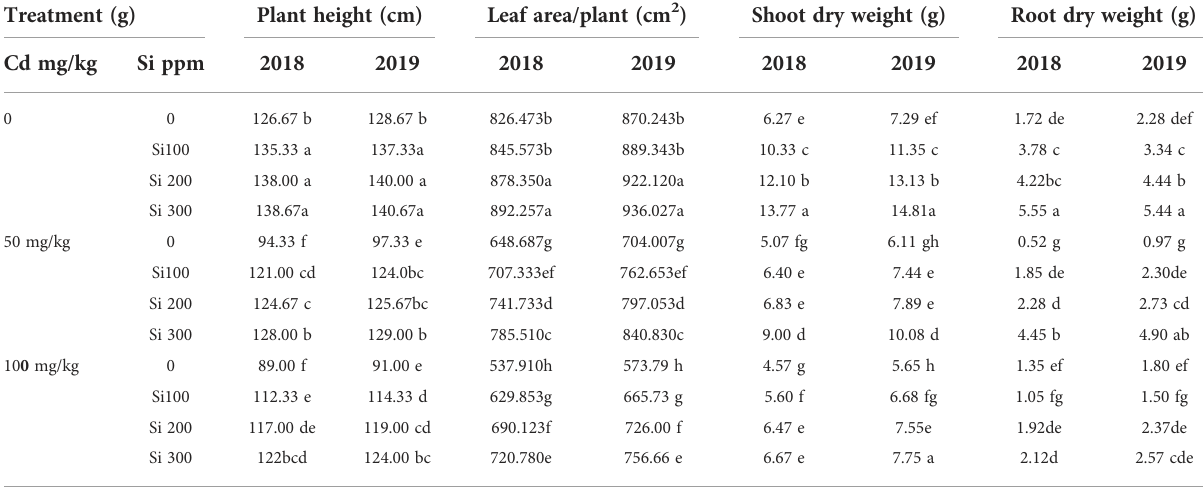
TABLE 2 Effect of foliar application of silicon on pea (plant height, leaf area, shoot and root dry weight) grown in different concentrations of cadmium (Cd) during 20182019 and 2019/2020 growing seasons. Treatment